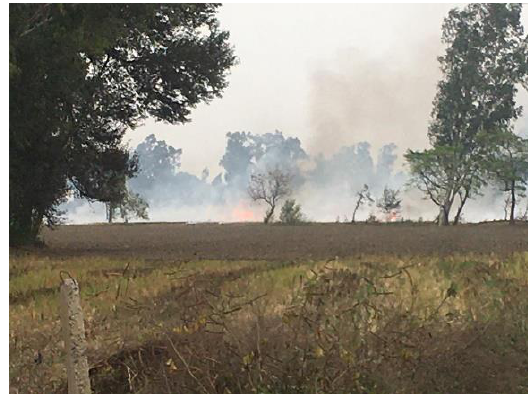
Figure 2: Crop residue burning in study area